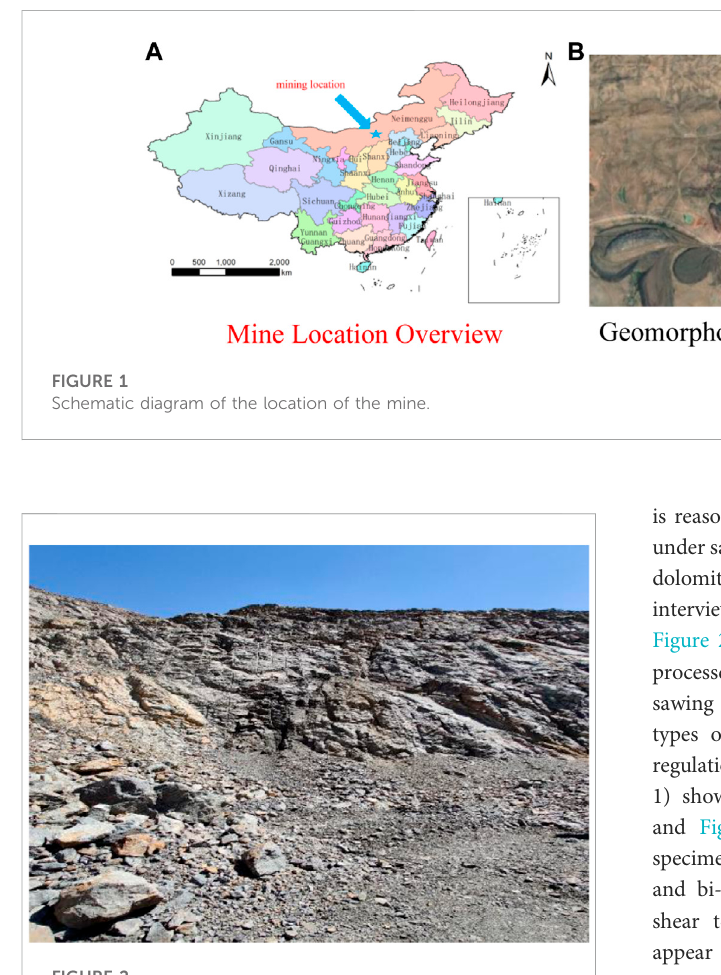
FIGURE 2 Field acquisition.